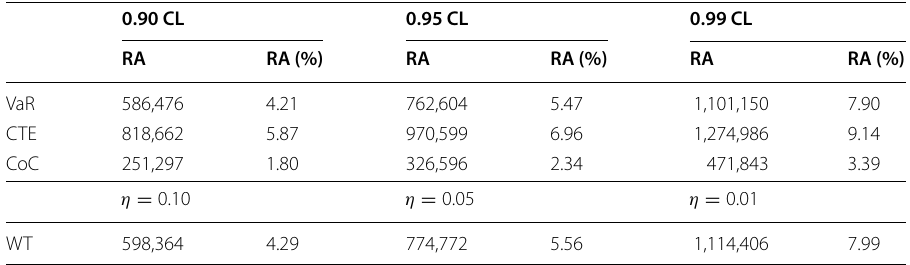
All RA amounts are in thousands in Canadian dollars